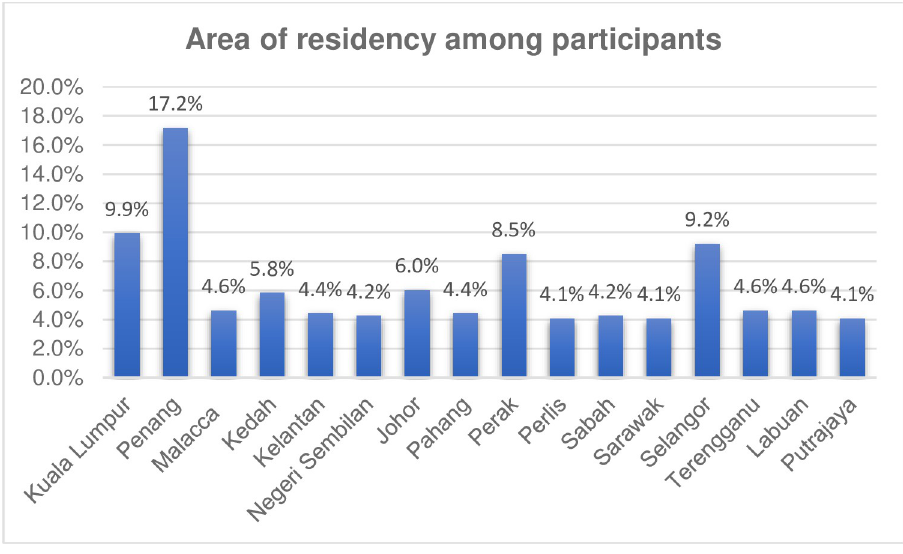
Fig 1. Area of residency among participants (N =